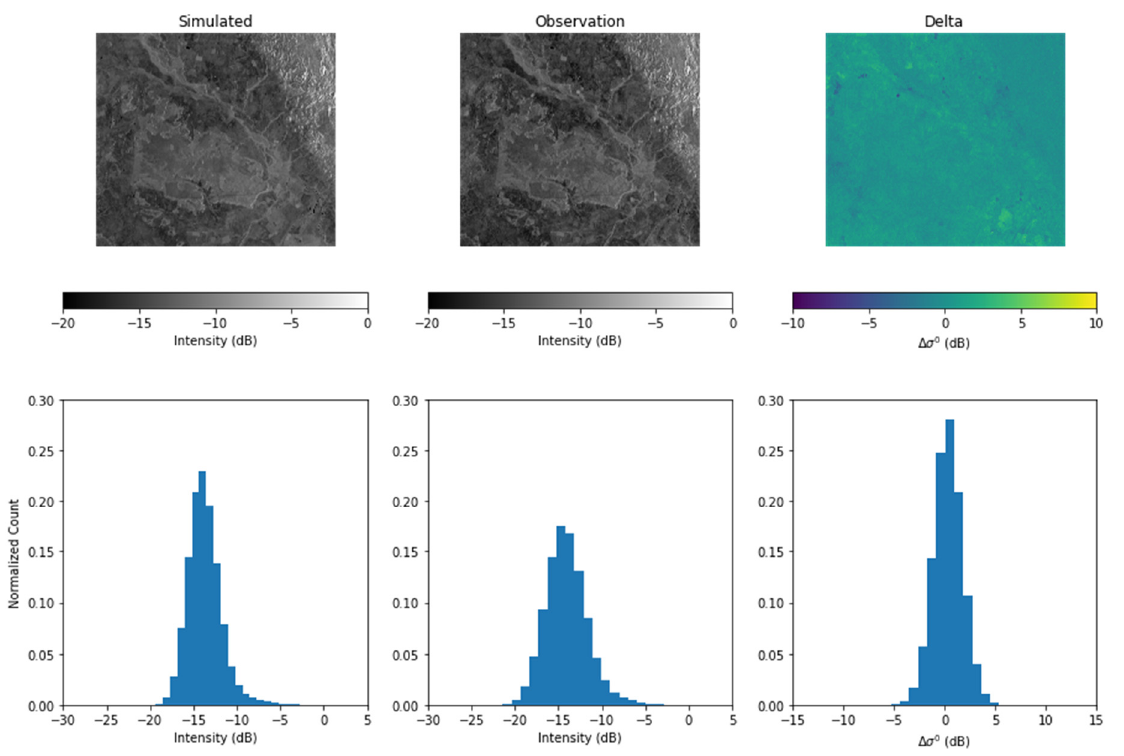
Figure 4. Simulated, real observation and Delta image with their respective histograms for VV polarization. Real observation corresponds to 20 December 2017.